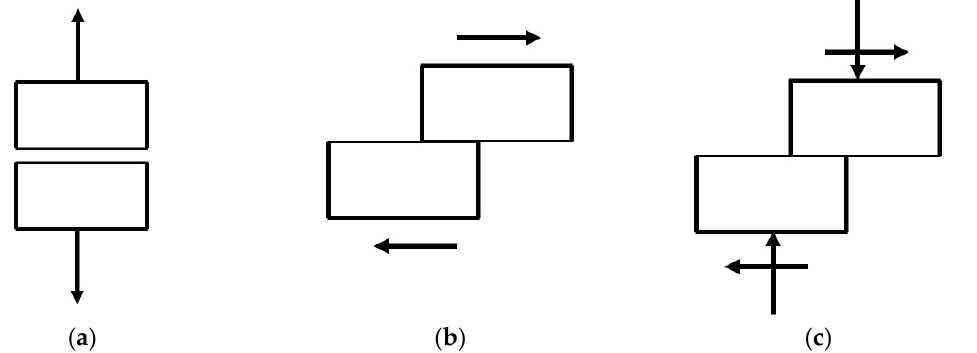
Figure 6. The effects of the normal stress σ n and the shear stress τ n . ( a ) Plane separation driven by the normal tensile stress; ( b ) plane sliding driven by the shear stress; ( c ) plane sliding under the combined shear stress and normal compressive stress.